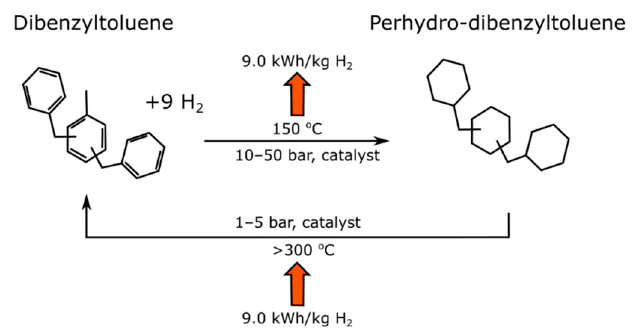
Figure 5. Hydrogen storage cycle for (perhydro-)dibenzyltoluene.